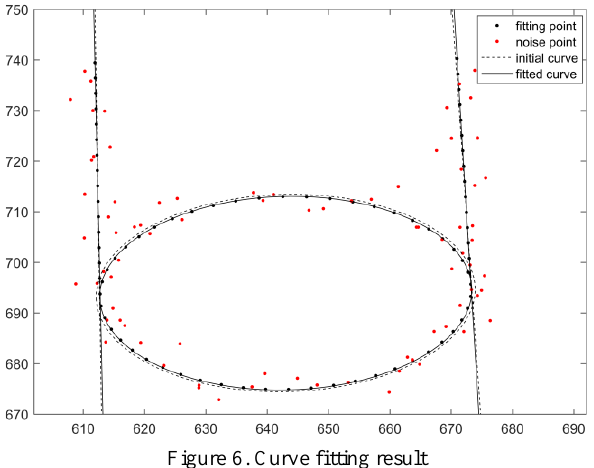
Figure 6. Curve fitting result